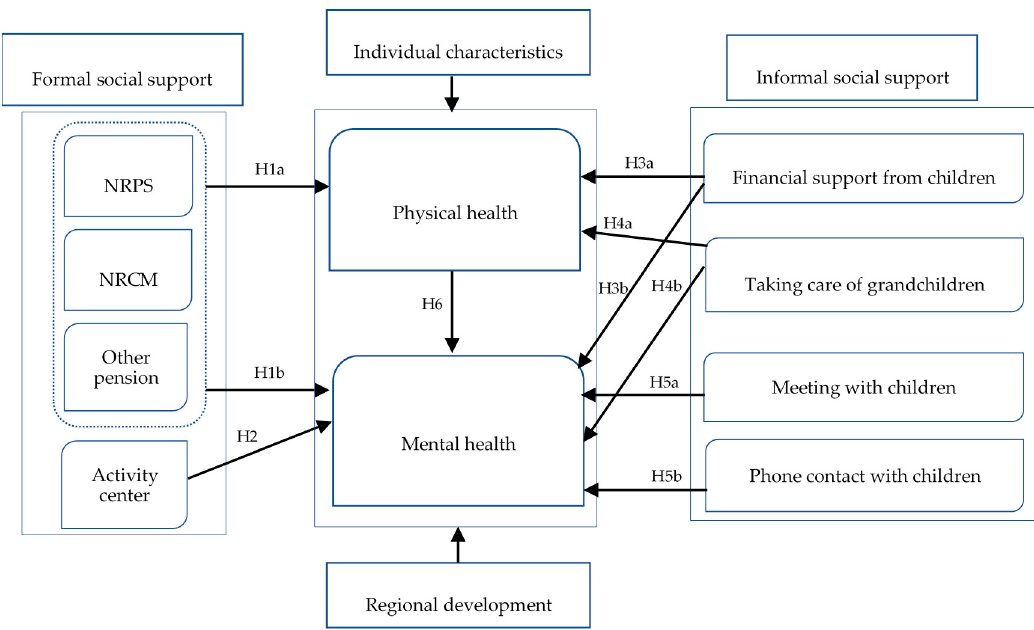
Figure 1. The framework of this study. NRPS, New Rural Pension Scheme; NRCM, New Rural Cooperative Medical.